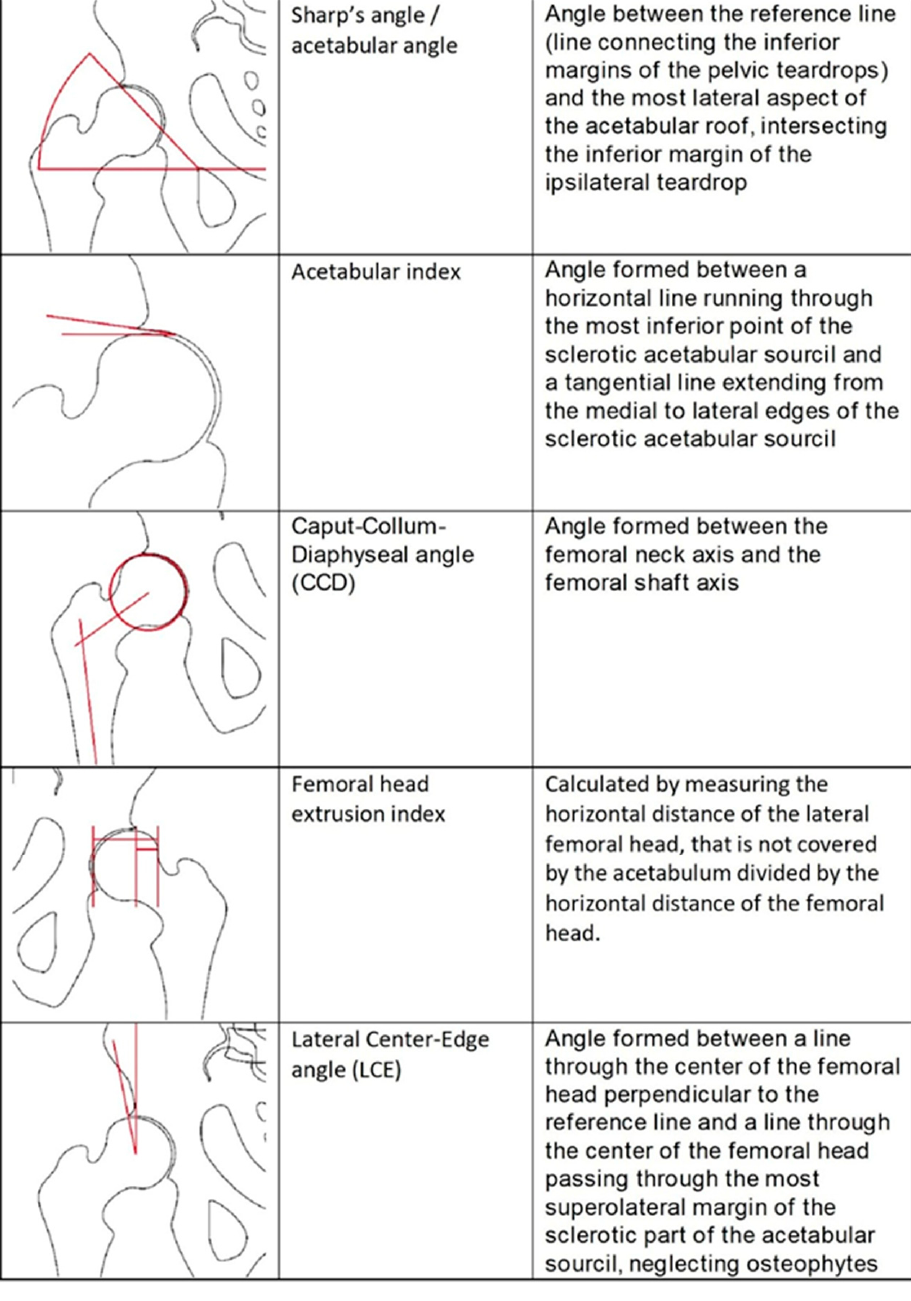
Figure 3. Radiographic measurement for the evaluation of the hip morphology used in this study.